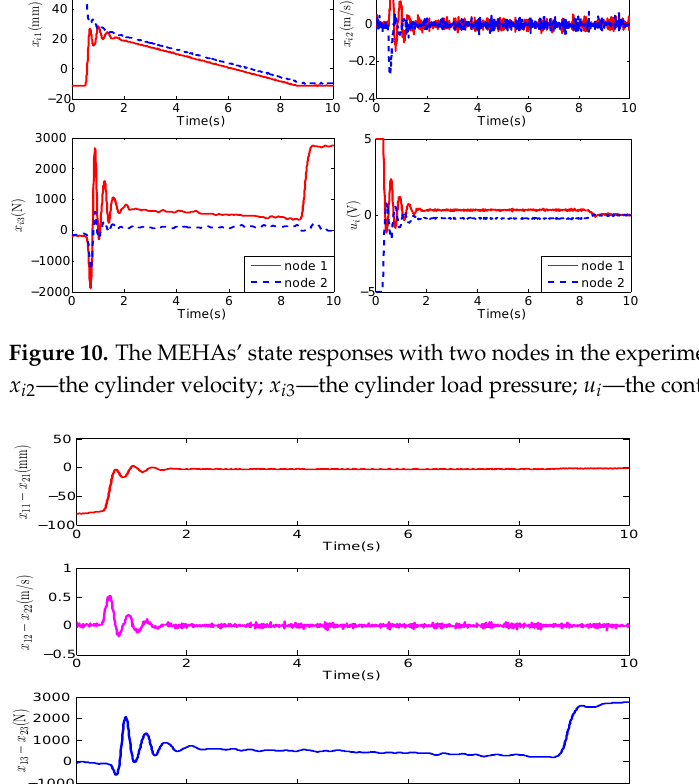
Figure 11. The MEHAs’ state errors of two nodes in the experiment: x 11 cylinder position error; x 12 line)—the cylinder load pressure